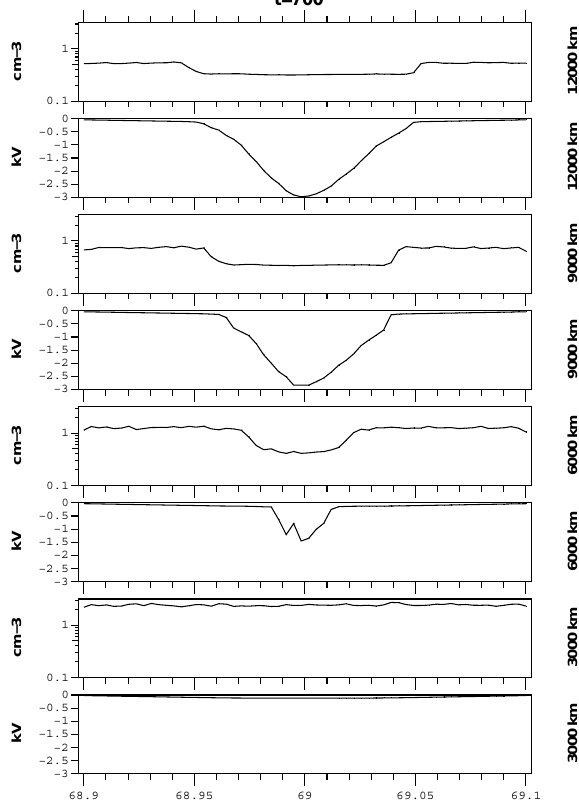
Fig. 10. Simulated satellite passes at 3000, 6000, 9000 and 12000km altitudes, showing the total plasma density and the plasma potential along the satellite orbit as a function of invariant